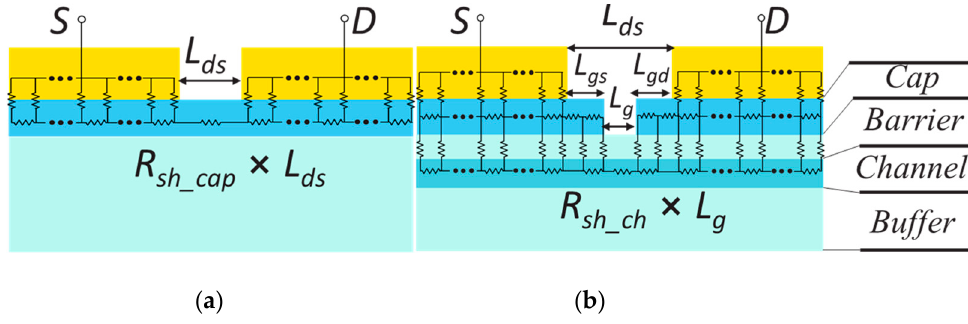
Figure 3. Cross-sectional schematic of cap-TLM ( a ) and recessed-TLM ( r-TLM ) ( b ). Table 1. Six boundary conditions, the general solution for three current components, and their corresponding eigenvalues and eigenvectors.